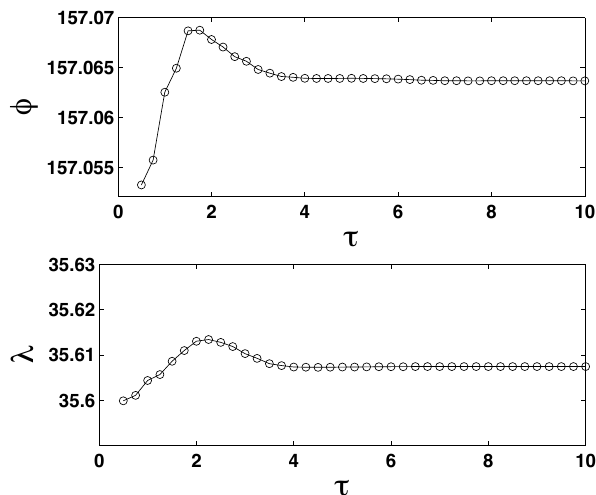
Fig. 11. Evolution of the longitude and latitude position of the hy- perbolic minimum of the function M on 2 May 2003 versus τ (in